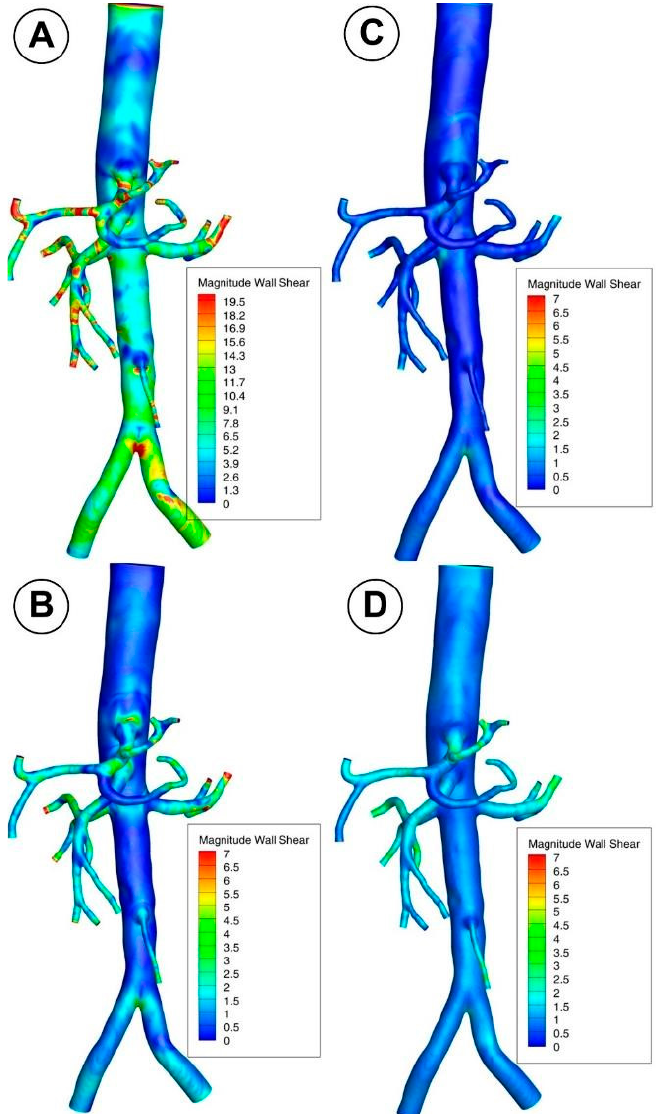
Figure 12. WSS distribution in the investigated abdominal aorta for different time steps. ( A ) T1 = 0.15 s; ( B ) T2 = 0.45 s; ( C ) T3 = 0.6 s; ( D ) T4 = 1 s.